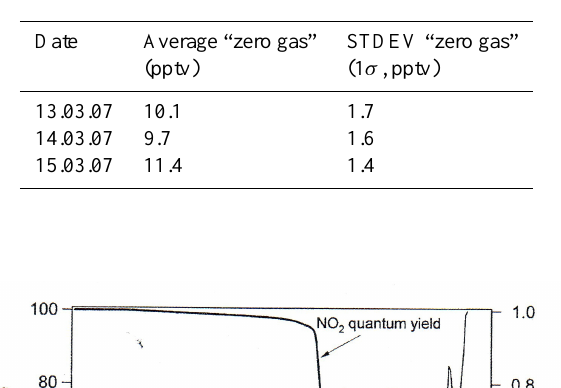
Table 3. Average and standard deviation of zero gas measurements for NO 2 .